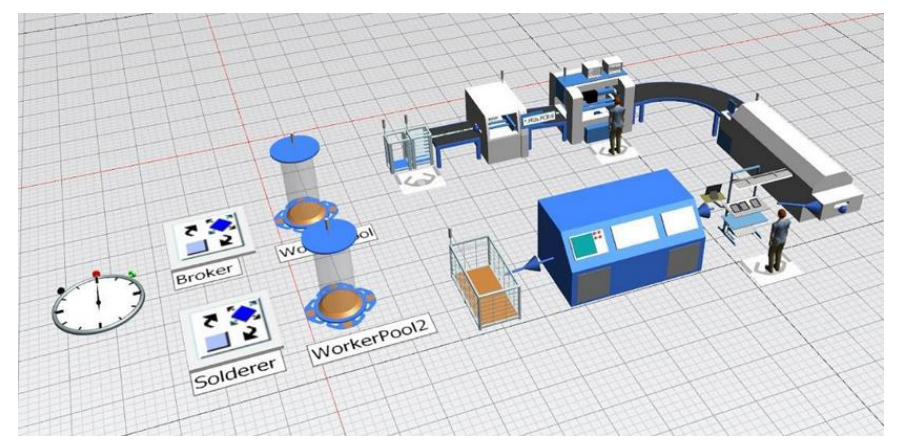
Fig. 6. The final simulation model of the assembly line.